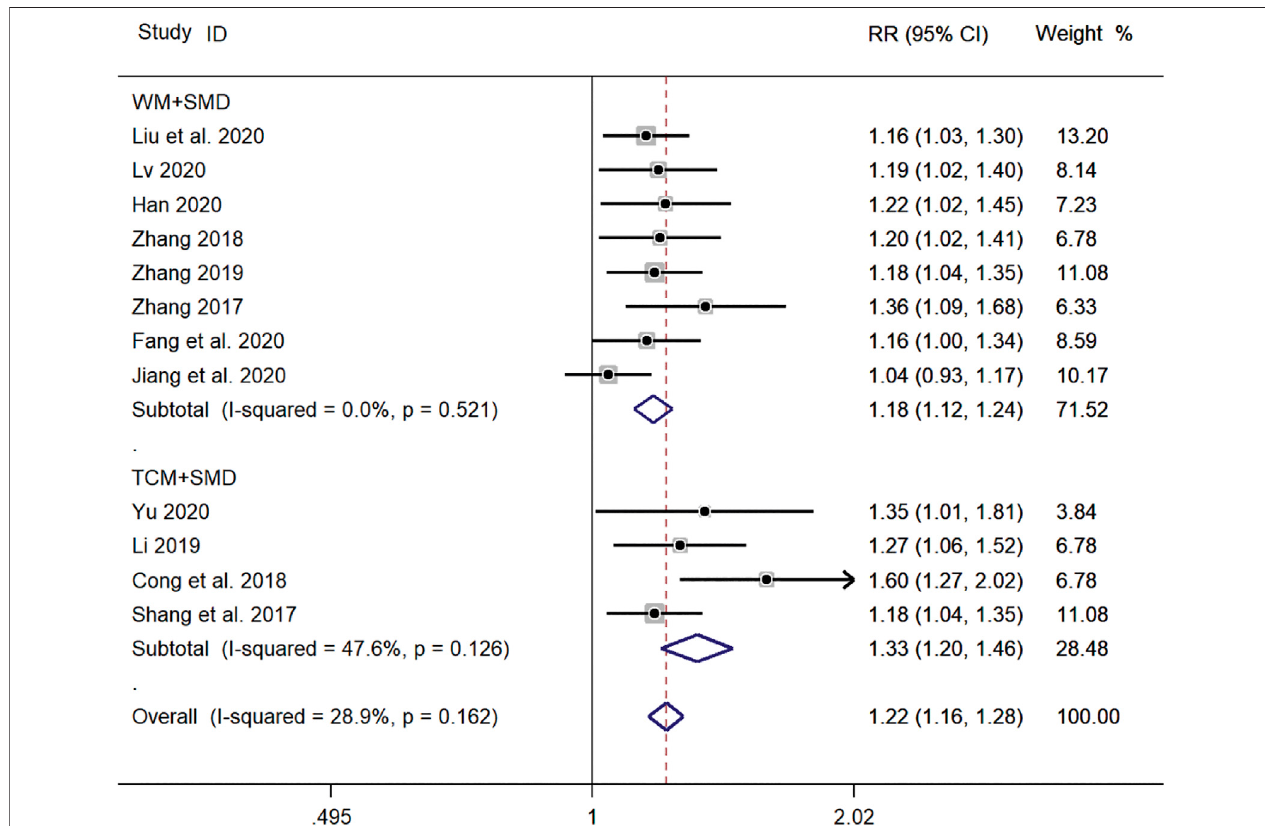
FIGURE 13 | Meta-analysis forest plot comparing the total ef fi ciency levels of the experimental group with the control group for subgroup analysis of different treatment methods. Note: SMD, Shashen Maidong Decoction; WM, Western Medicine; TCM, Traditional Chinese Medicine.